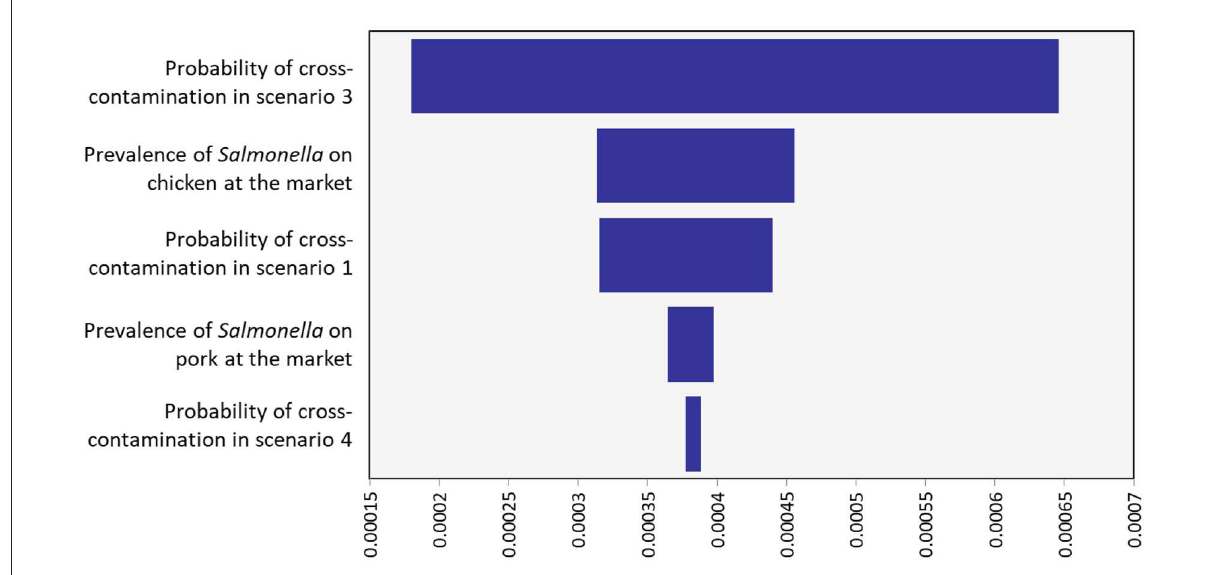
FIGURE3 Sensitivity analysis of influence factors on annual salmonellosis incidence due to consuming both pork and chicken salad.